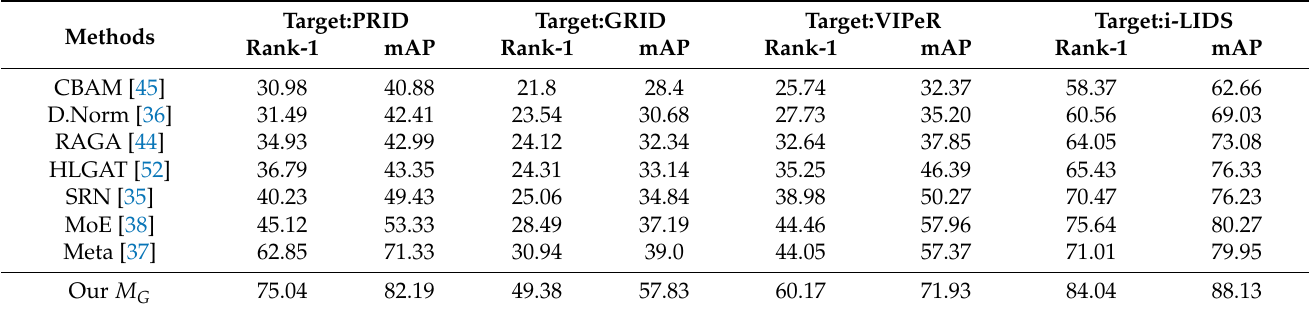
Table 4. Results on Challenging Close-Set